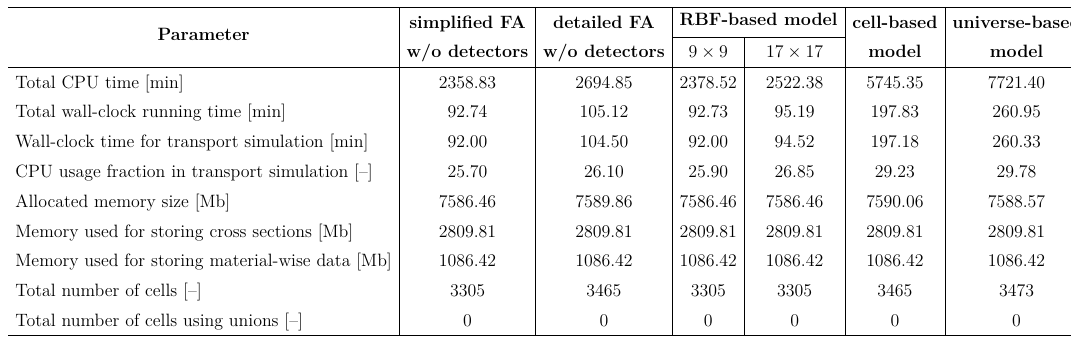
Table 3. Comparison of Serpent2 simulation characteristics for different cases.